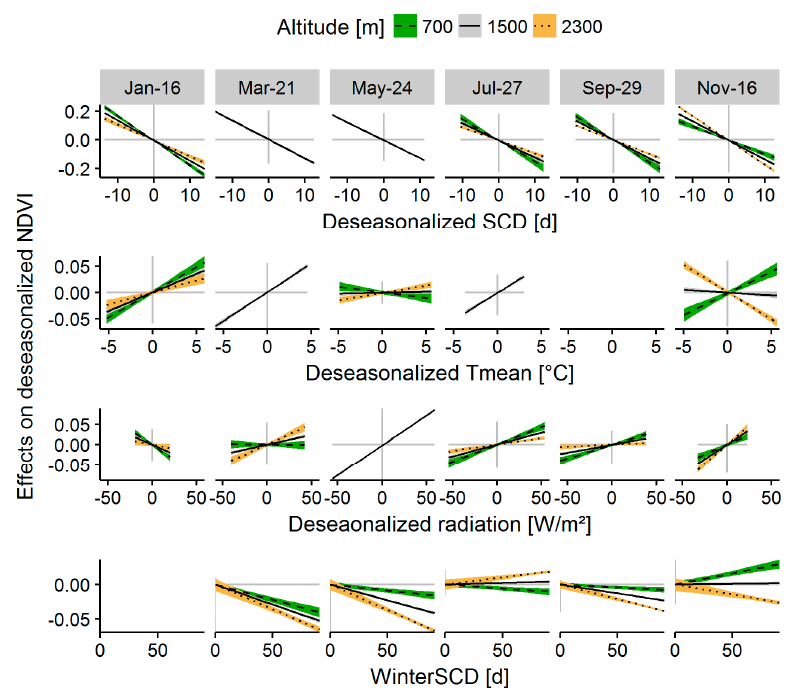
Figure 16. Influence of climate variability measured in the respective unit days [d], degree Celsius [C°], and watt per square meter [W/m 2 ] on NDVI at selected dates throughout the year and depending on altitude. Shown are effects (slopes/coefficient of the regression models) of deseasonalized climate variables on deseasonalized NDVI at three altitudes (700, 1500, and 2300 m, which correspond approximately to the 5, 50 and 95% quantiles) and heat load index of 0.75 (approximately the sample average), holding other variables constant. If lines for 700 m and 2300 m are missing, the interaction with altitude was not significant. In empty panels the coefficient of the climate variable was non-significant or, in the case of Winter SCD in January, not included in the model. Shaded areas denote 95% confidence intervals. For more details see Figures S7 and S8.